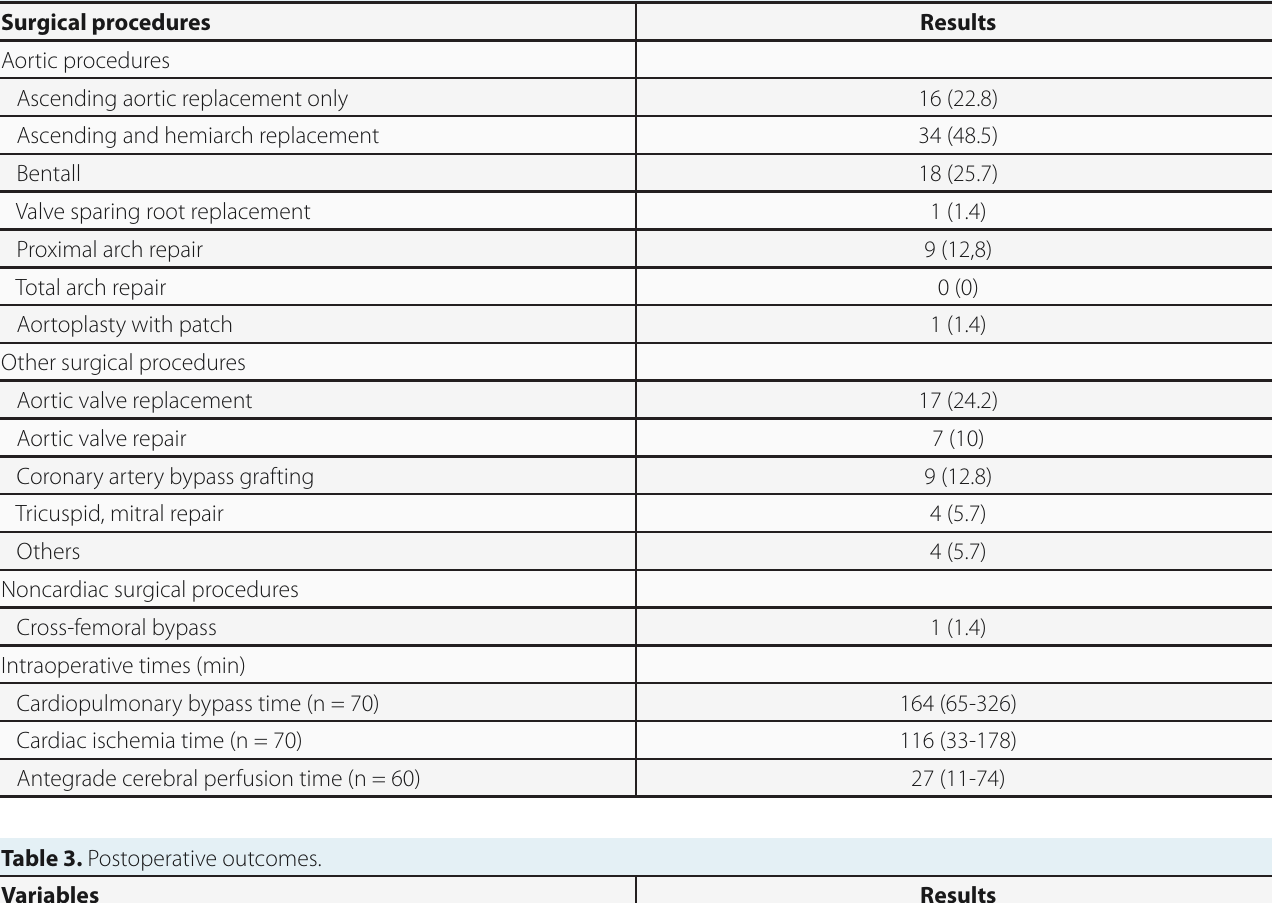
Table 2. Operative procedures and times.